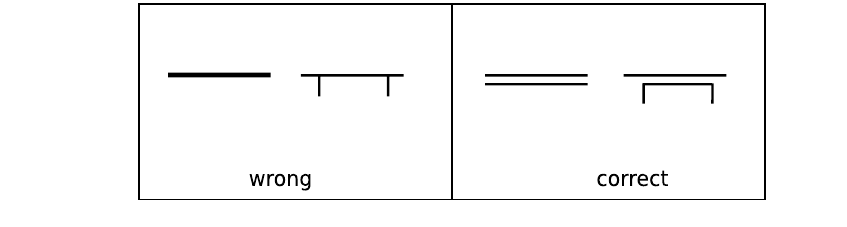
Figure 4.3: Edges must not overlap node borders.